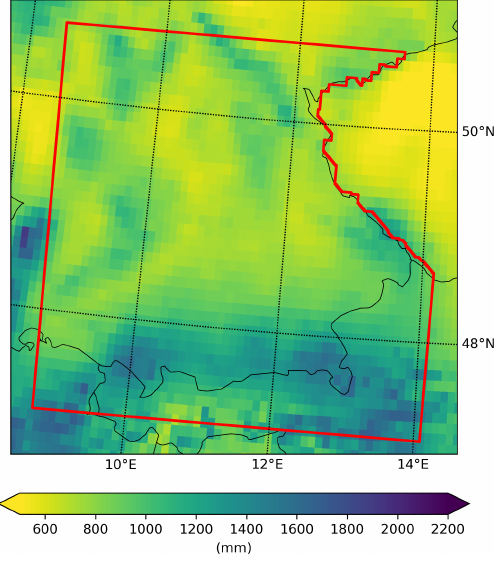
Figure 2. Annual mean precipitation for the period 1980–2009 based on E-OBS (Haylock et al.,